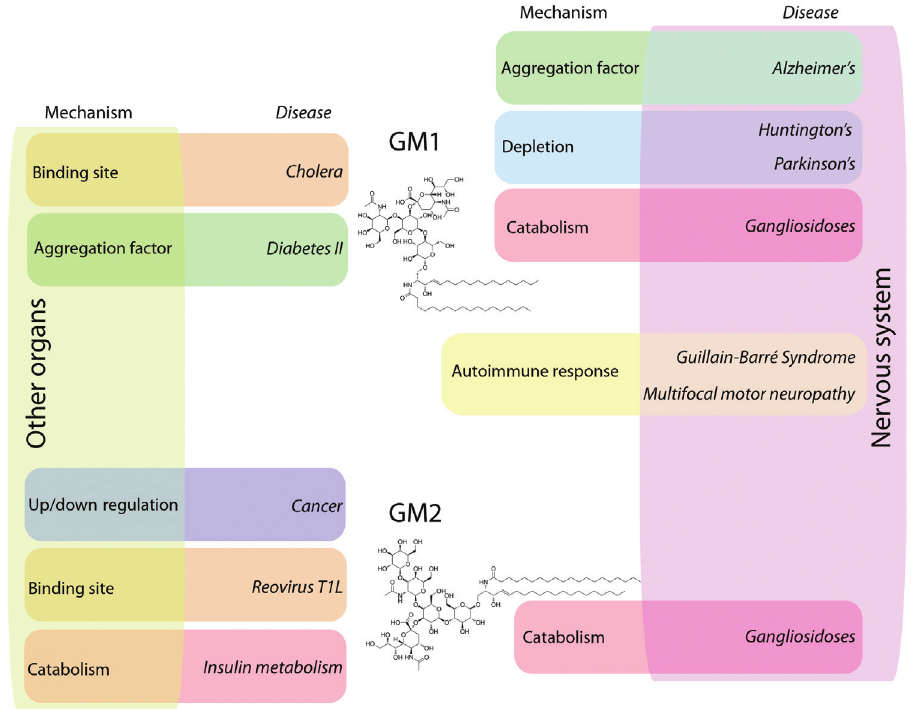
Figure 1 Pathological involvement of GM1 and